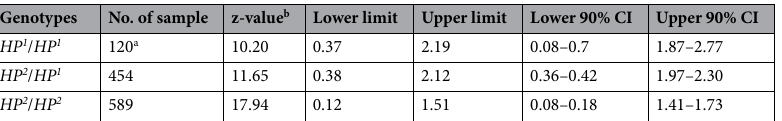
Table 2. Reference intervals for different HP subtypes. a The sample size for the HP 1 / HP 1 subtype was supplemented to 120 to accommodate the requirements of EP28-A3c guideline. b Weighted alternative approach was used for HP subtype grouping, resulting in one z-value per subclass; The value of z* is 6.60.